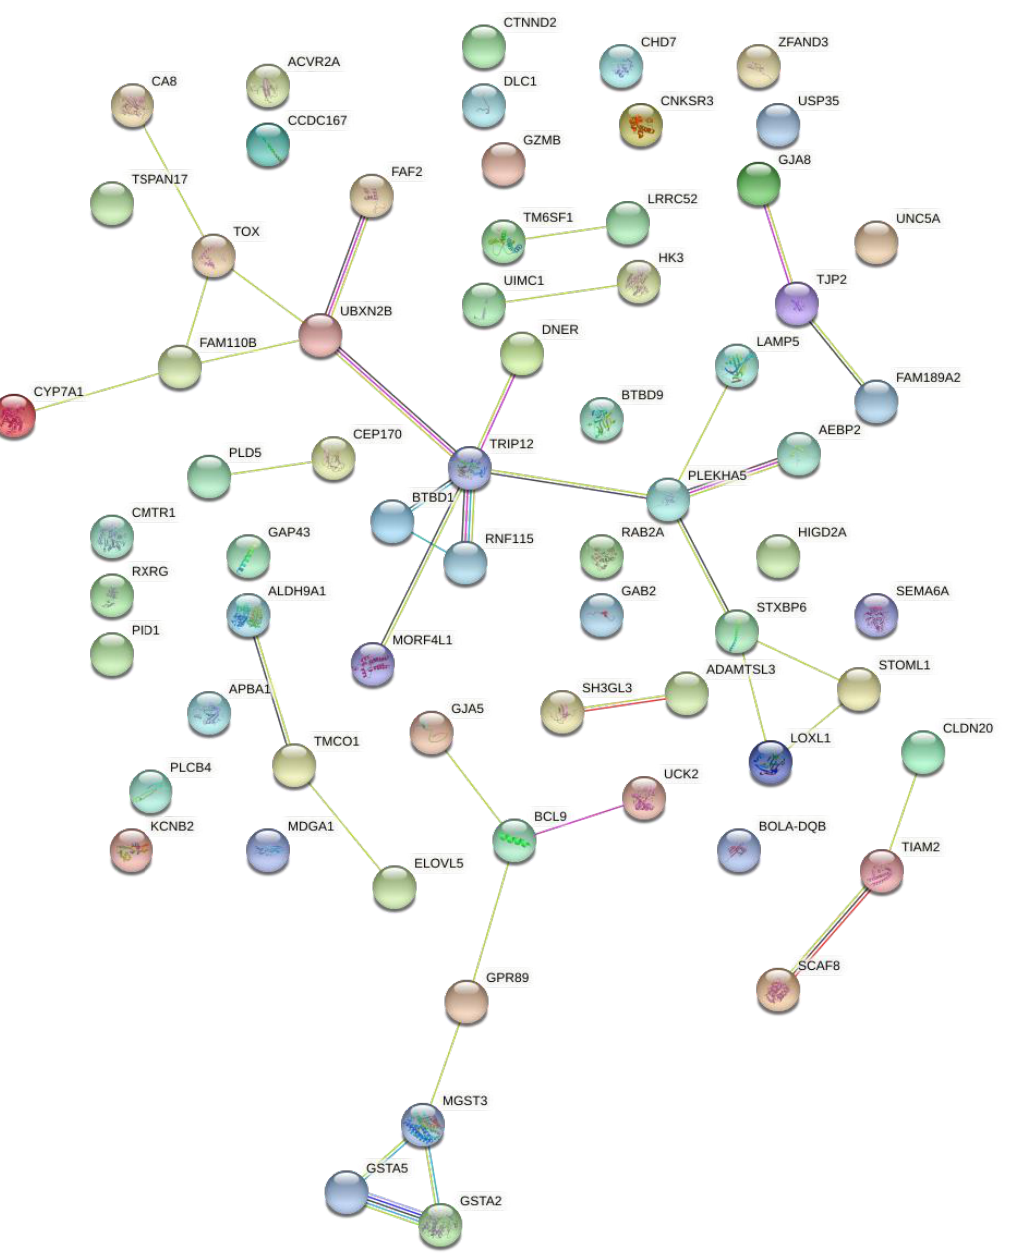
Figure 5. Genetic interaction network of genes simultaneously associated with conformation, precocity, and muscling traits based on visual scores in Nellore cattle.